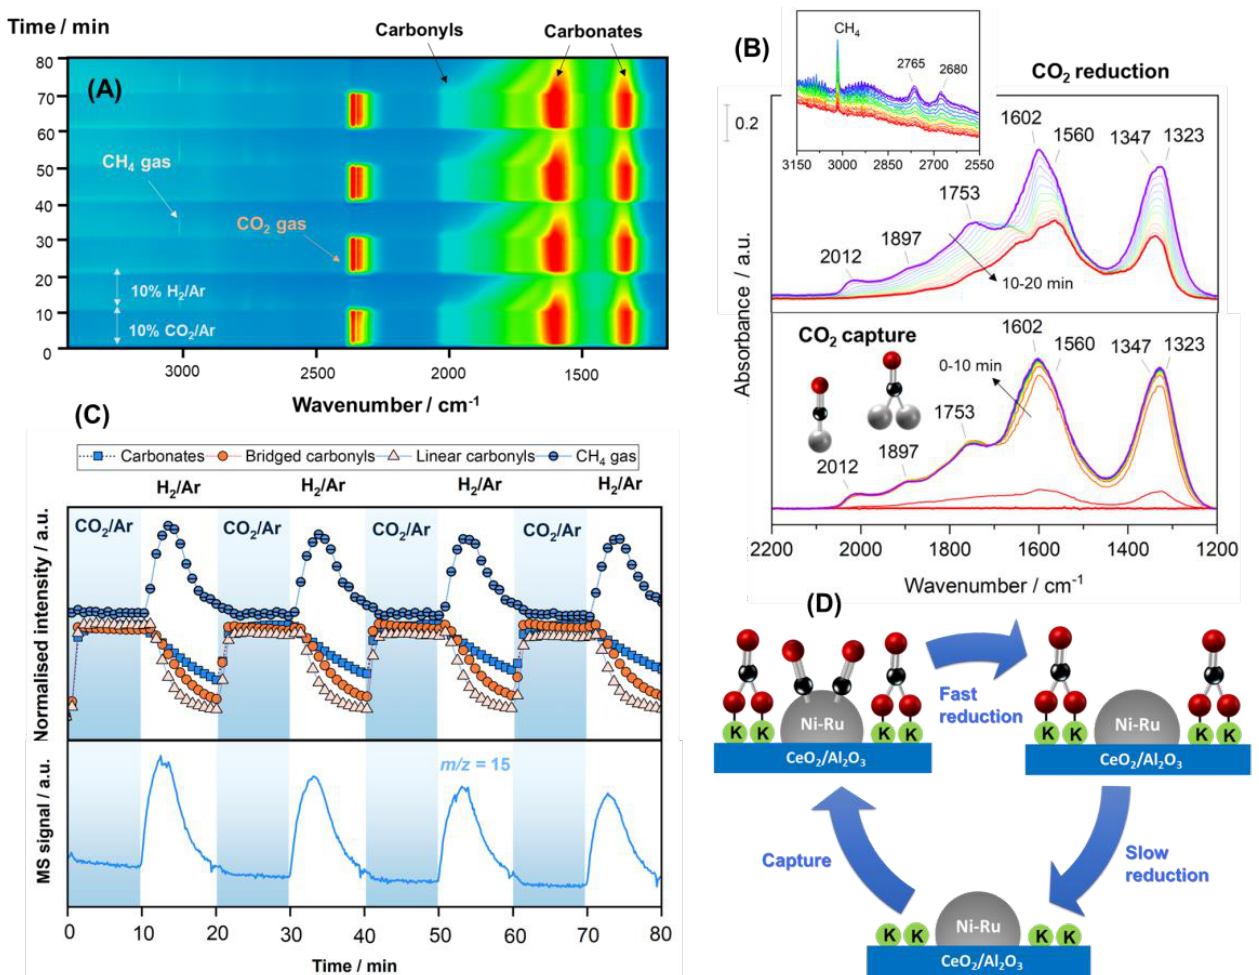
Figure 6. ( A ) Bidimensional representation of time-resolved DRIFTS spectra on a reduced NiRuK/CeAl sample at 250 ºC during capture/reduction cycles (10% CO 2 in Ar and 10% H 2 in Ar, both at 50 mL min − 1 ). The spectrum after activation pretreatment was taken as background. ( B ) Representative evolution of spectra during the first cycle of capture/reduction. ( C ) Evolution of selected IR bands and of a m/z = 15 (CH 4 ) signal during the capture/reduction cycles. ( D ) Illustrative sketch of the capture/reduction process on NiRuK/CeAl.